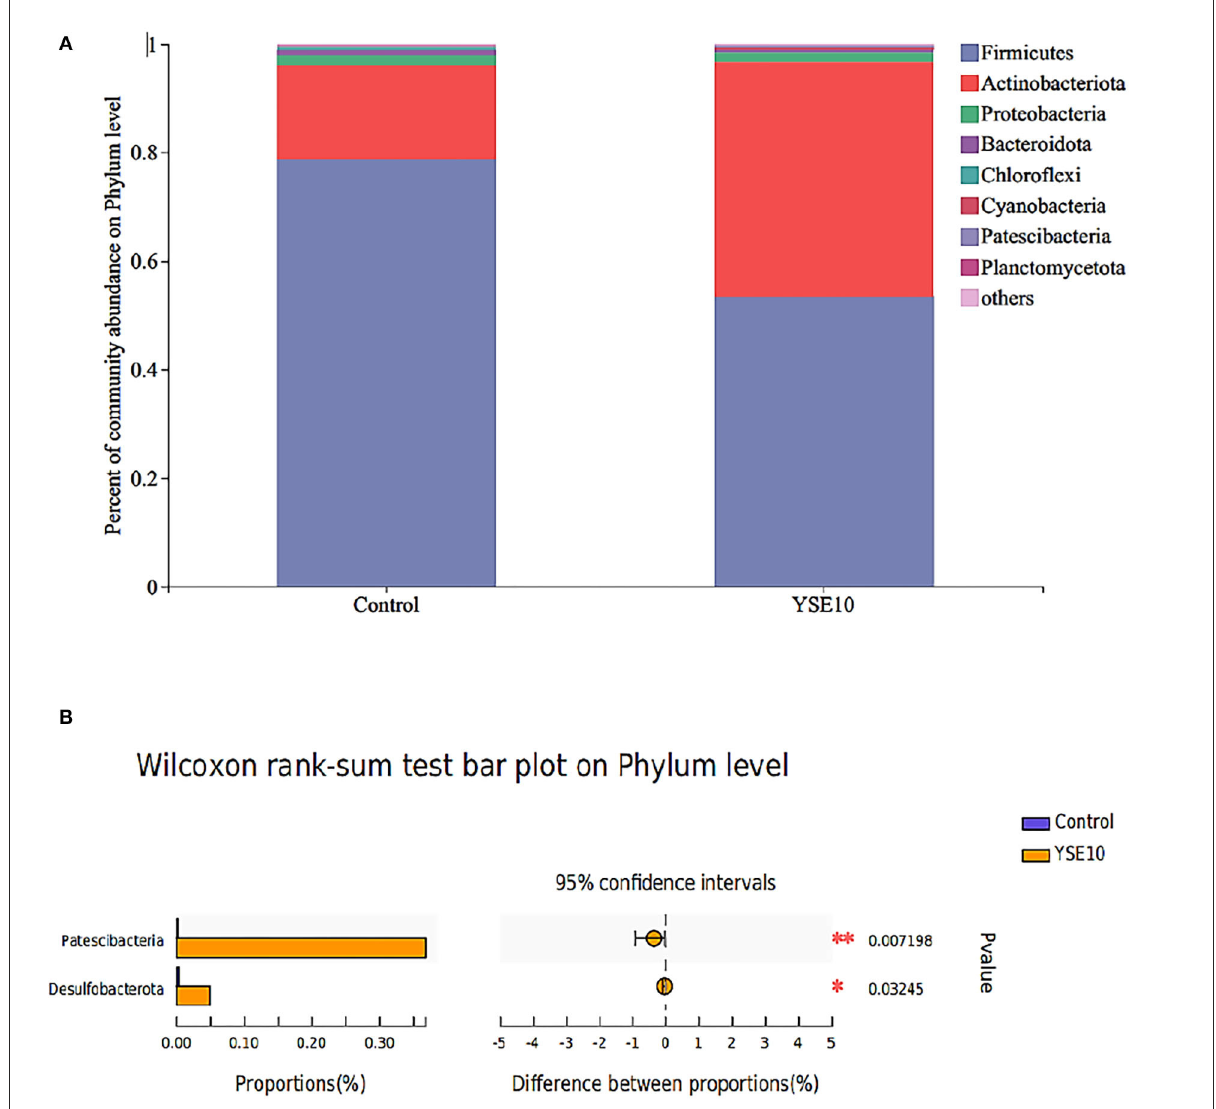
FIGURE1 The composition of microbiota and the comparison of differences at the level of phylum in the ileum of young pigeons. (A) Percent of community abundance. (B) Wilcoxon rank-sum test bar plot. The relative abundances of phylum in all samples’ sequence < 0.01 are classified as “others”. Control, 0.9% NaCl solution; YSE10, 10 mg/mL